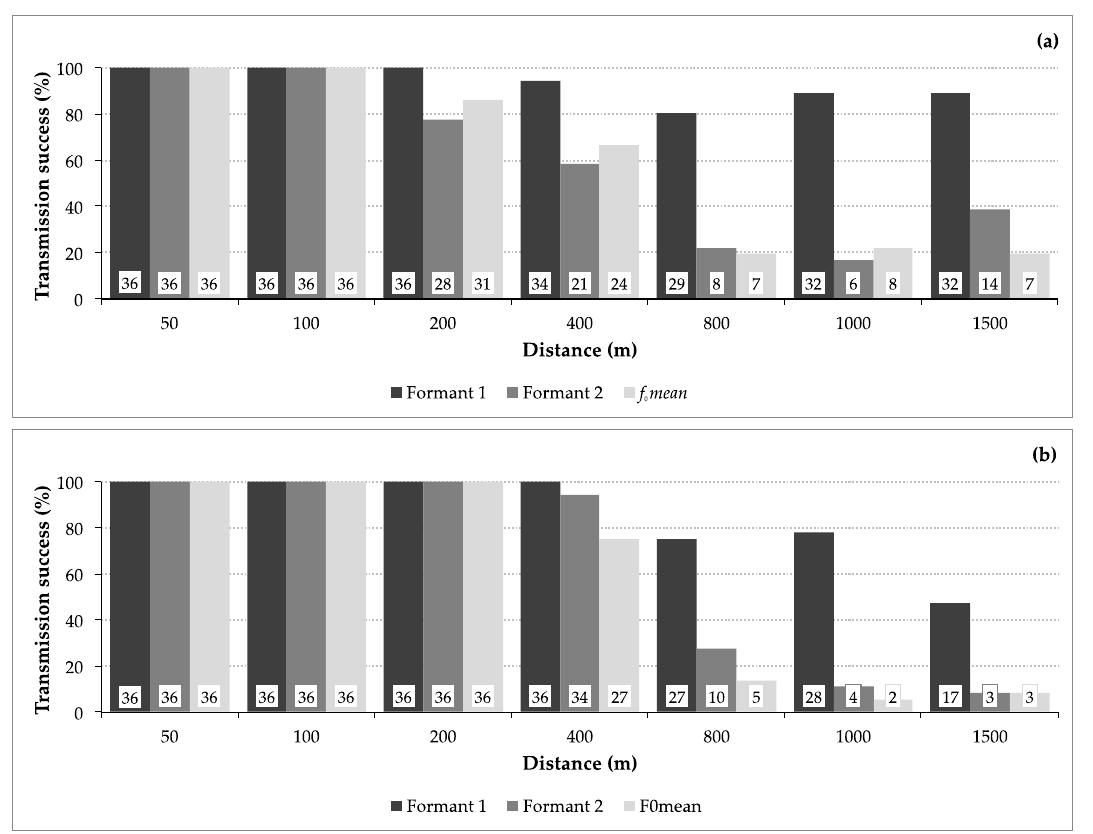
Figure 4. Transmission success (in percent) of F1 , F2 , and f o mean : Comparison of each acoustic feature between the ( a ) dense and ( b ) open habitat over 50 to 1500 m distance. Values given at the bottom of the bars indicate the absolute number of recordings successfully transmitted per distance.